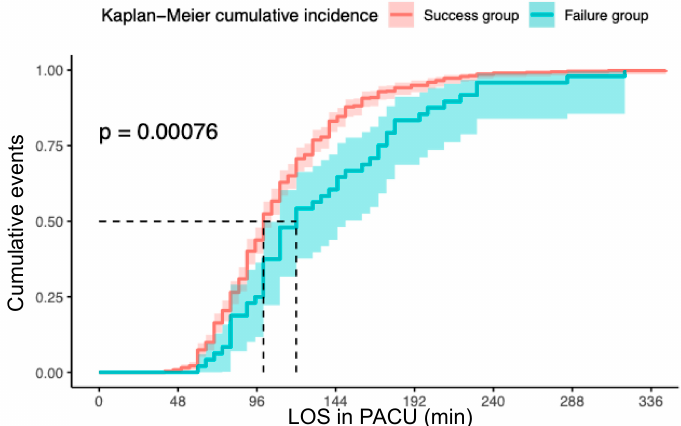
Figure 2. Kaplan–Meir estimation of the cumulative incidence of return to the street by overall care time. Abbreviations: LOS, length of stay.